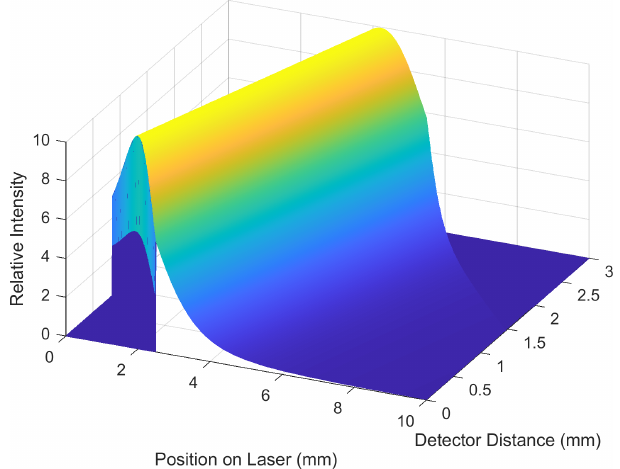
Figure 6. Normalized power detected by an ideal integrating neph- elometer, a PMS with an unpolarized light source, and a PMS with a perpendicularly polarized light source plotted as a function of par- ticle diameter. Modeled light source wavelength is 657nm, and the particle index of refraction is 1.53. See the explanation of the dif- ferent curves in the